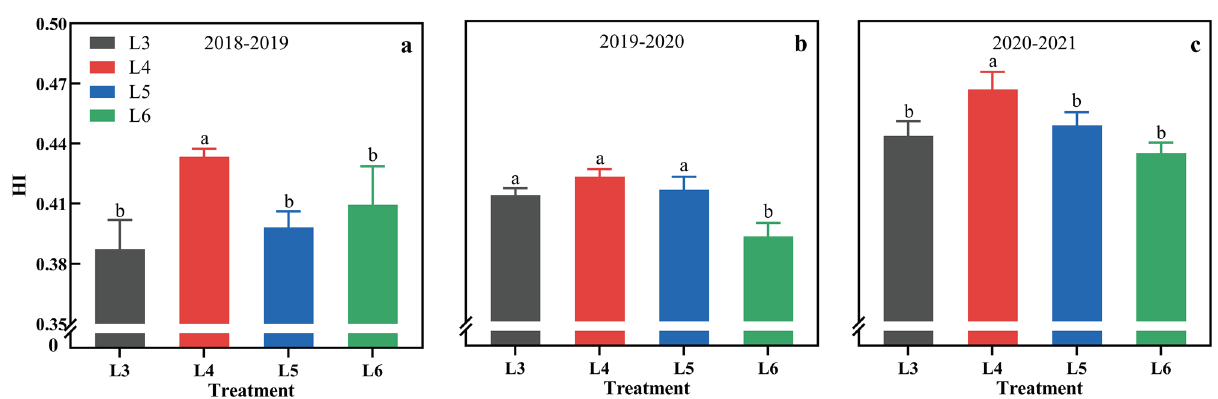
Figure 4. Effects of different irrigation treatments time on dry matter accumulation (DMA) at flowering and DMM at maturity in 2018–2019 ( a ), 2019–2020 ( b ) and 2020–2021( c ).